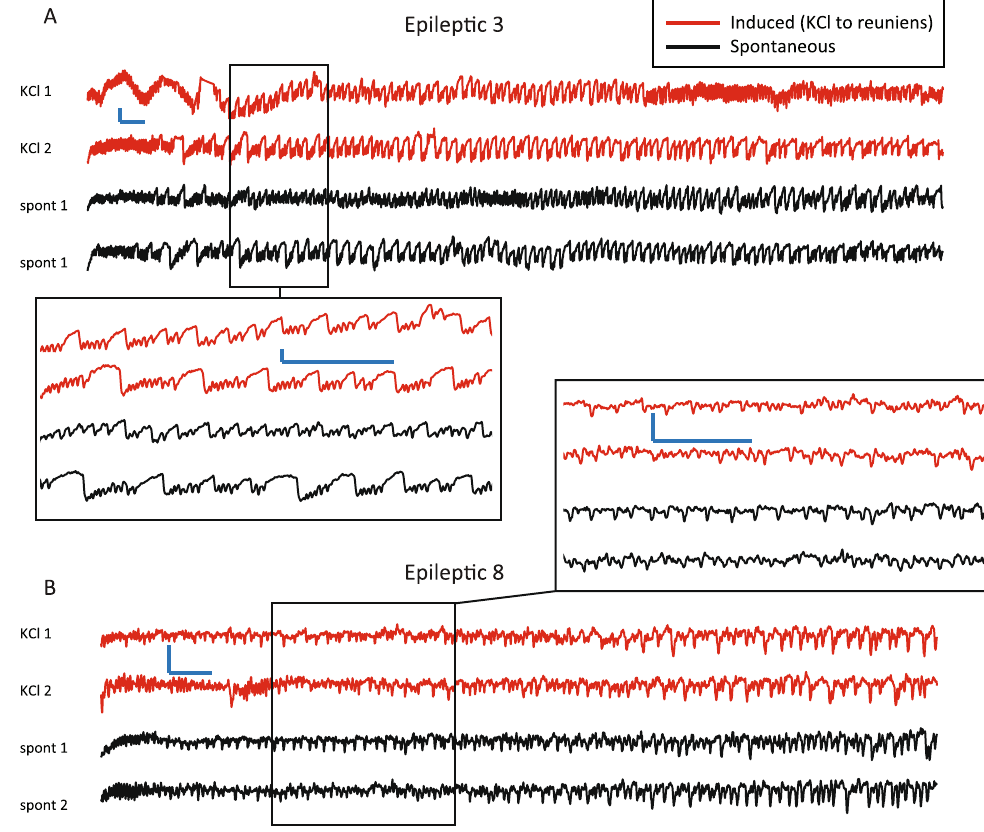
to the spontaneous seizures (spont 1, 2) recorded on other days in the same animal (black). Note that in both animals there were no spontaneous seizures in the 3 hours prior to the experiment; these spontaneous